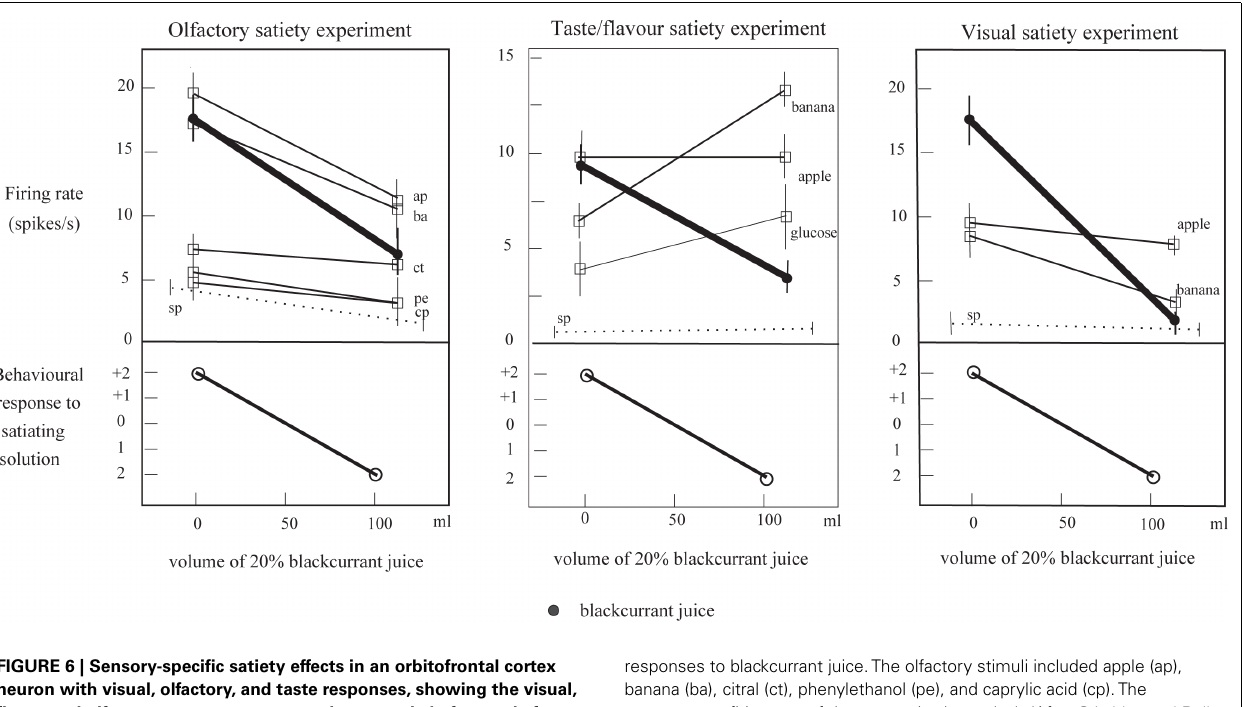
FIGURE 6 | Sensory-specific satiety effects in an orbitofrontal cortex neuron with visual, olfactory, and taste responses, showing the visual, flavor, and olfactory responses measured separately before and after feeding to satiety with blackcurrant juice. The solid circles show the